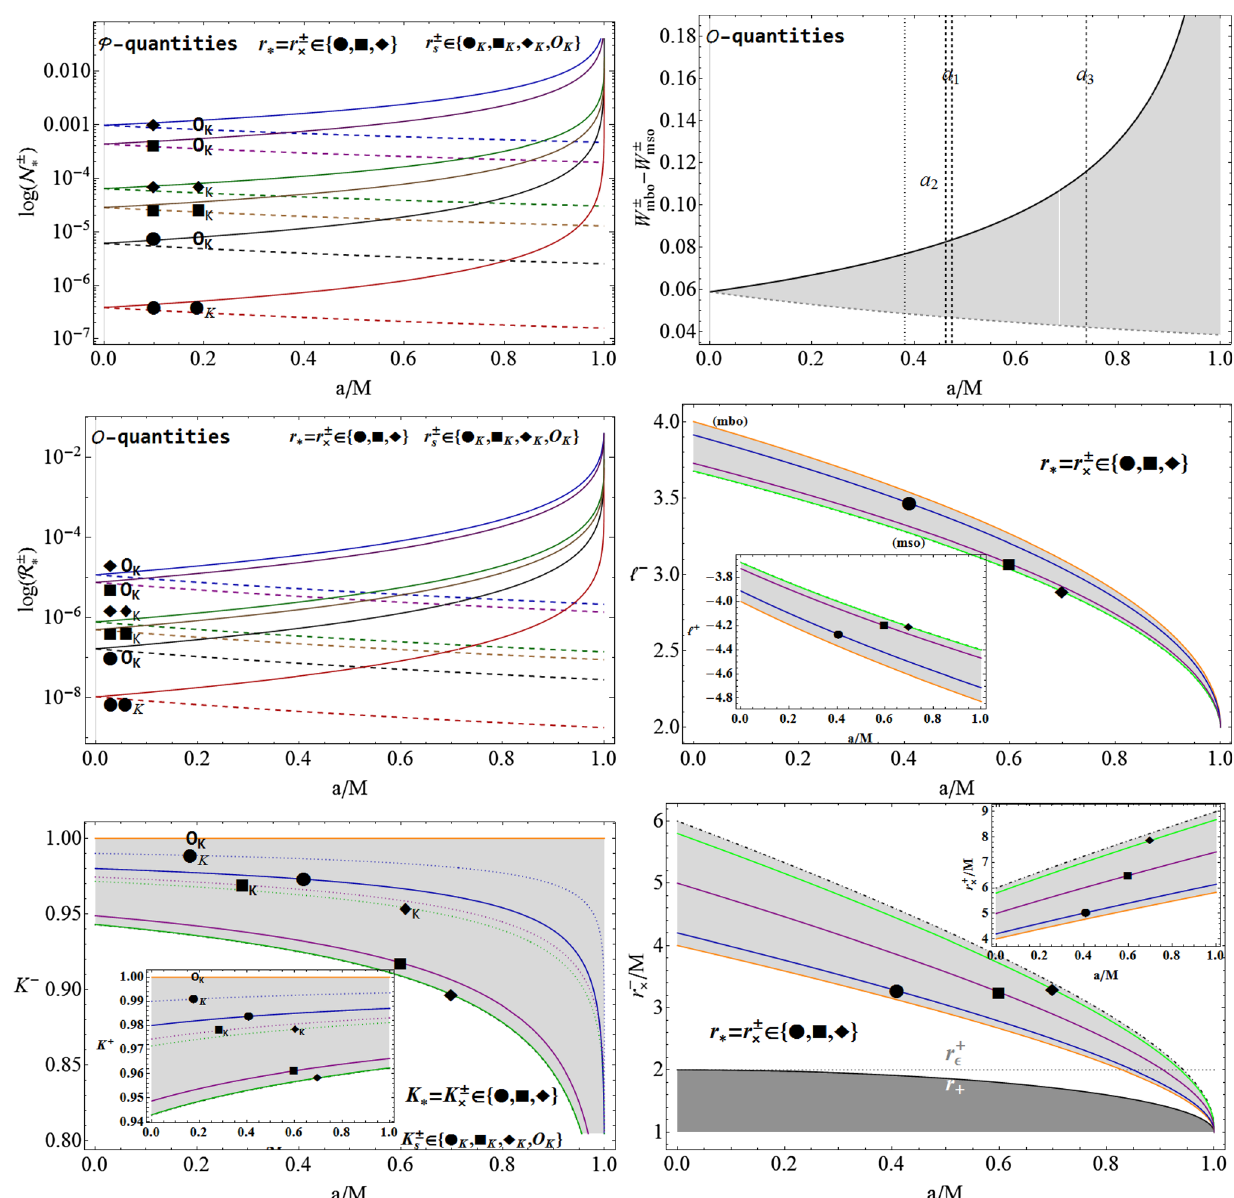
Fig. 15 Evaluationof P -and O -quantitiesofTable2forcorotatingand r s ∈ {• K , (cid:8) K , (cid:9) K , O K } where (cid:25) = n + 1, with γ = 1 / n + 1 is the counterrotating tori, versus black hole dimensionless spin a / M . Plots polytropic index. Radii ( r ∗ , r s ) and the correspondent angular momen- of N ± ∗ ≡ r ∗ ( W ± ( r s ) − W ± ∗ ) κ (Ω K ( r ± ∗ )) − 1 ( upper left panel ) for P - tum (cid:4) and K parameters are shown with {• , (cid:8) , (cid:9) , • K , (cid:8) K , (cid:9) K , O K } . Ω quantities analysis; the maximum difference ( W ± ( r mbo ) − W ± ( r mso )) K is the Keplerian angular velocity, r × is the accreting tori cusp (inner ( upper right panel ) (Eqs. (22, 23)) and R ± ∗ ≡ ( W ± ( r s ) − W ± ∗ ) κ ( center edge of accreting torus), r s is related to thickness (cid:21) h s of the accreting left panel ), for O -quantities analysis as functions of SMBH dimension- matter flow as in Fig. 11. r mbo is the marginally bounded orbit. Ω + less spin a / M , for corotating ([ - ] – continuum curves) and counterrro- been considered for the counterrotating fluids. The maximum location tating ([ + ] – dashed curves) tori at different r ∗ = r ± × ∈ {• , (cid:8) , (cid:9) } and of inner edge is r × (cid:4) r mso (cid:6) (cid:6) (cid:6) (cid:6) (cid:6) (cid:6) (cid:6) (cid:6) ≥ G − = G − 0,where G − ,while G − , themselves as shown in Fig. 15, this result may be inter- ¯ p ( 2 ) − (cid:2) ˘ p ( 2 ) − (cid:2) ¯ p ( 2 ) − (cid:2) ˘ p ( 2 ) − (cid:2) preted as the combined effect of the increasing SMBH spin, ( 2 ) ± , ˘ p ( 2 ) ± ) are two gen- asymptotically for a = M , and ( ¯ p (cid:2) (cid:2) and the approaching of ( r s , r × ) to the central attractor, which eral couples of parameter, therefore associated to two differ- means an increase of the dragging effects. Viceversa, in ( 2 ) − , ˘ p ( 2 ) − ) are functions of a / M ent curves in Fig. 15. As ( ¯ p (cid:2) (cid:2)